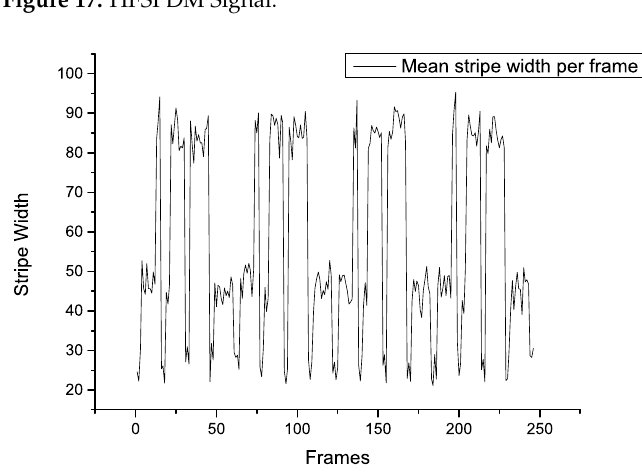
Figure 17. HFSPDM Signal.